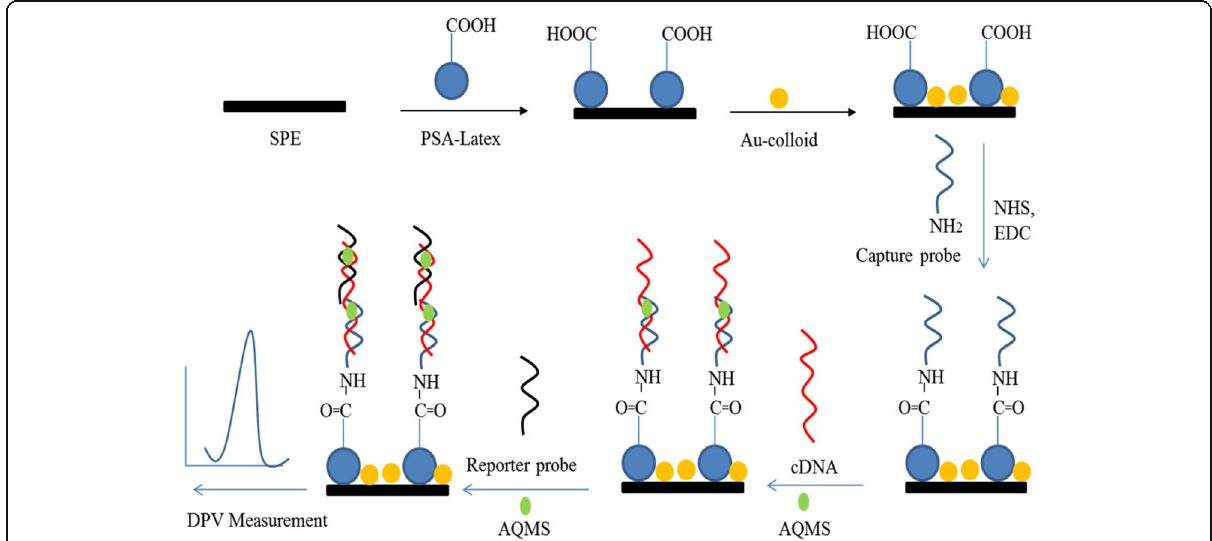
Fig. 1 Schematic representation of DNA biosensor stepwise fabrication